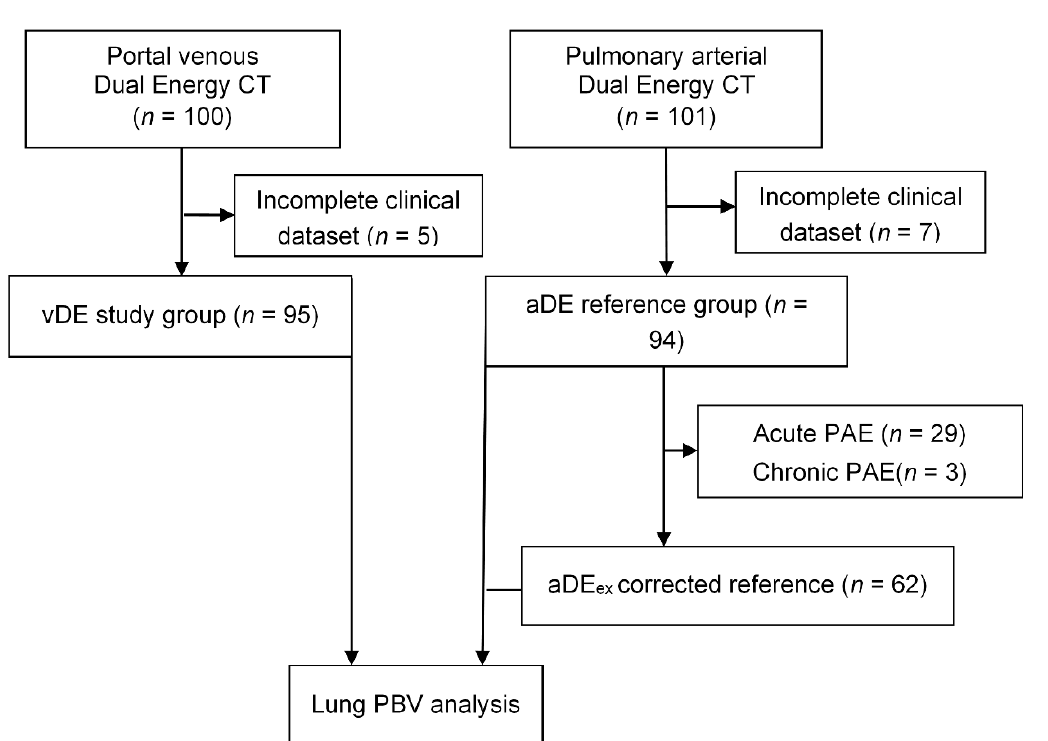
Figure 1. Flowchart of study design (vDEportal-venous thoraco-abdominal Dual Energy CT, aDE—pulmonary arterial Dual Energy CT, PAE—pulmonary arterial embolism, aDEex—subgroup of aDE with exclusion of PAE patients, PBV—perfusion blood volume). Table 1. Dual-energy protocols for portal–venous thoraco-abdominal CT in the study group (vDE— portal-venous thoraco-abdominal Dual Energy CT) and pulmonary arterial CT of the chest in the reference group (aDE—pulmonary arterial Dual Energy